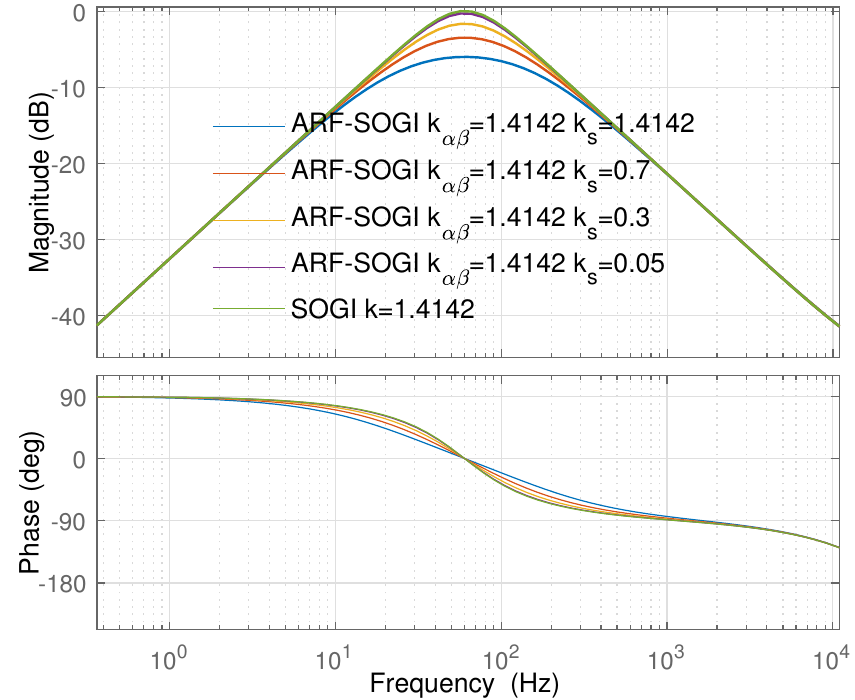
Figure 4. Bode diagrams of the SOGI-QSG versions for v (cid:48)